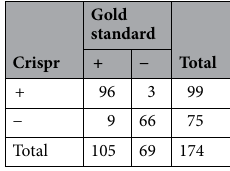
Table 5. Consistency analysis of cryopreserved sample groups between Crispr and direct sequencing method in IDH1-R132H detection.